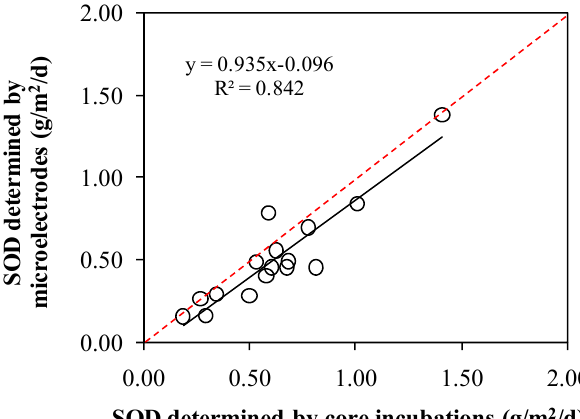
Figure 7. Comparison of SOD determined by core incubations and by microelectrodes. The red dotted line represents the ideal value when the two methods are identical.